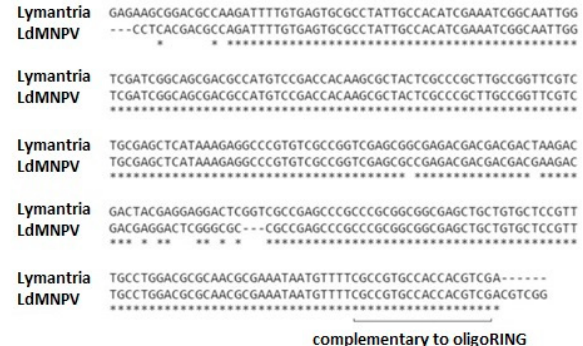
Figure 1. Alignment of the sequenced DNA fragments of gypsy moth and nucleopolyhedrovirus (LdMNPV) IAP-3 gene fragments performed using ClustalW 2.0.3; identities found by simple comparison of the sequences are marked with *.